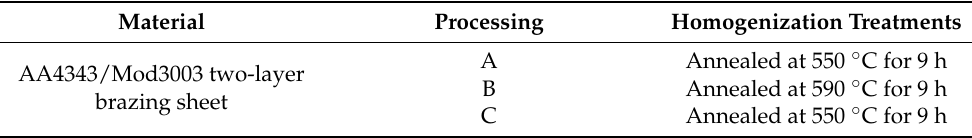
Table 1. Different homogenization annealing treatments of the experimental